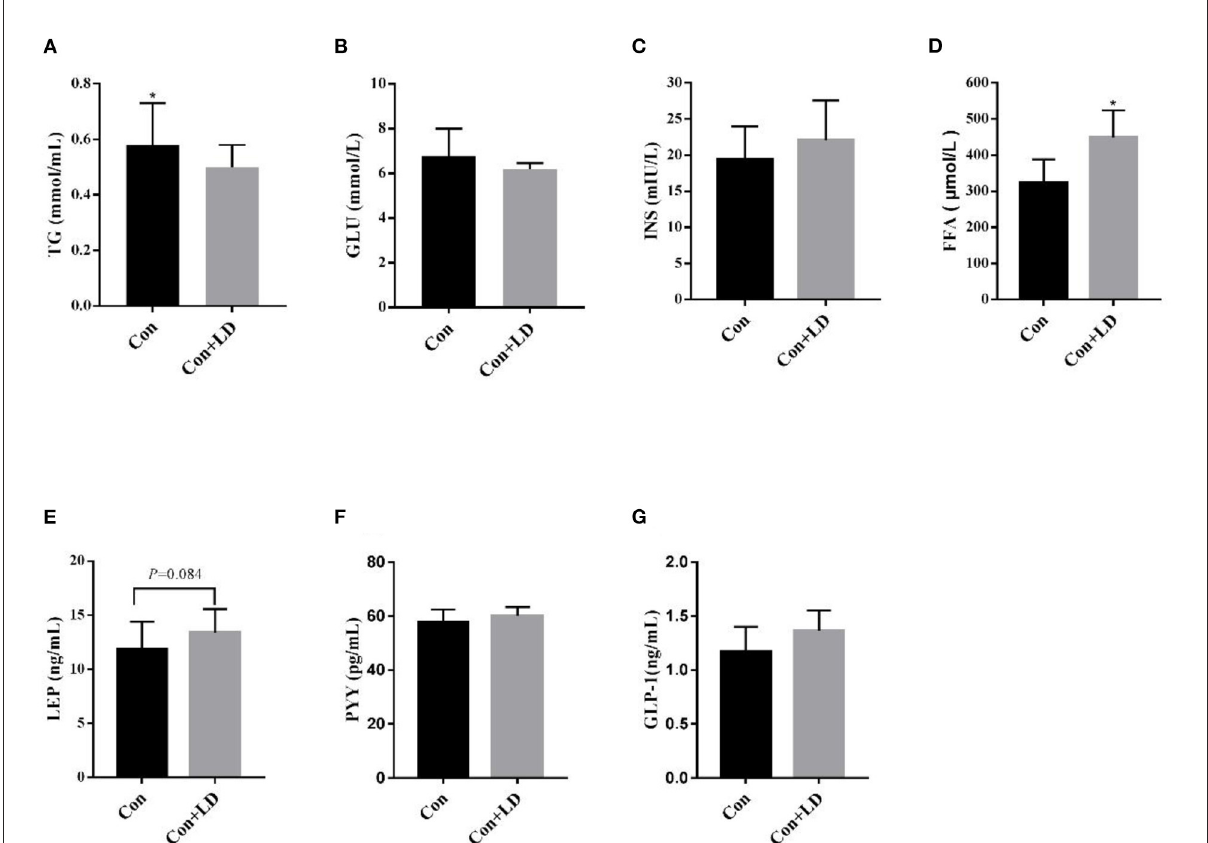
FIGURE1 Serum levels of lipids and hormone in growing-finishing pigs. Values for histogram are shown as Mean ± SEM, * P < 0.05. (A) TG, triglyceride; (B) GLU, glucose; (C) INS, insulin; (D) FFA, free fatty acids; (E) LEP, leptin; (F) PYY, peptide tyrosine tyrosine; (G) GLP-1, glucagon-likepeptide-1; Con, basal diet; Con + LD, basal diet + 0.1 % L. delbrueckii